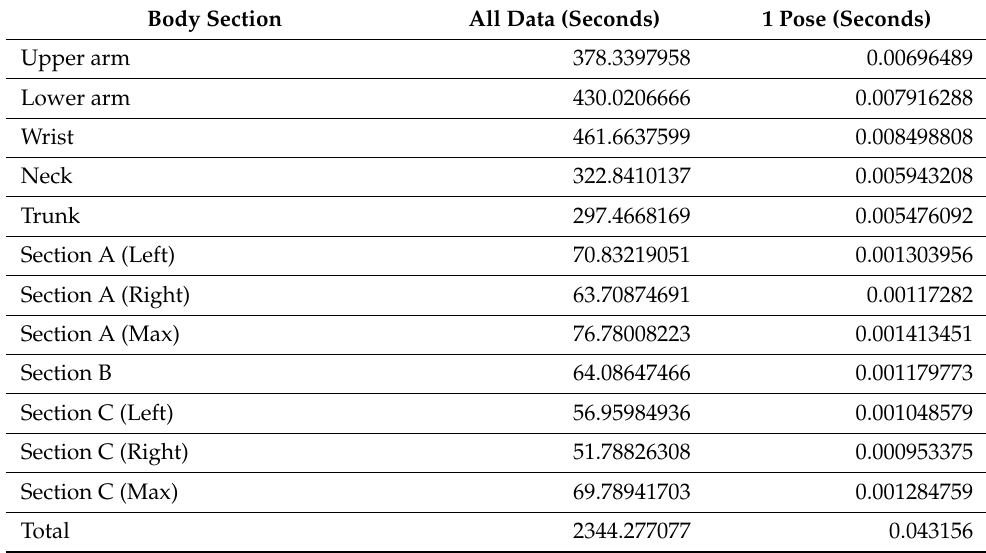
Table A3. The execution time required to determine the RULA